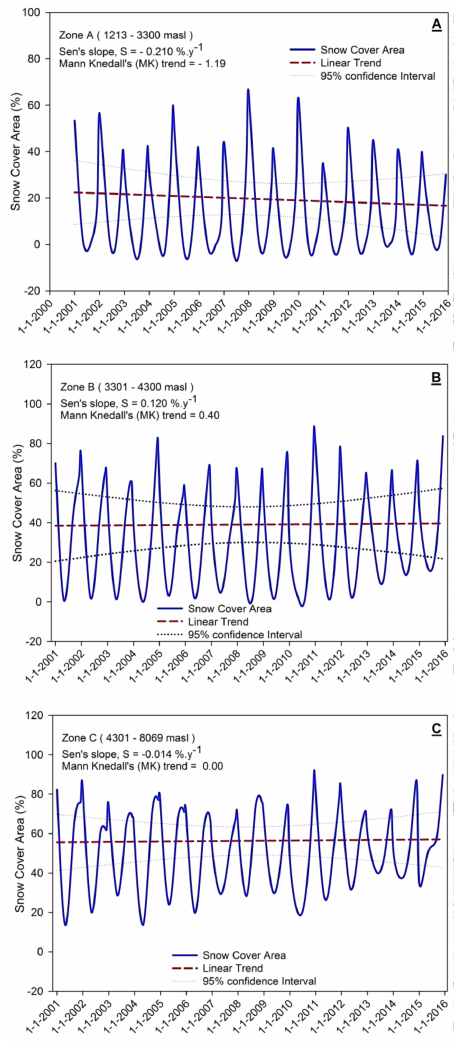
Figure 6. The trend of the MODIS-data derived snow-covered area of the Astore River basin, in three altitudinal zones shown in ( A – C ), over a 15-year period